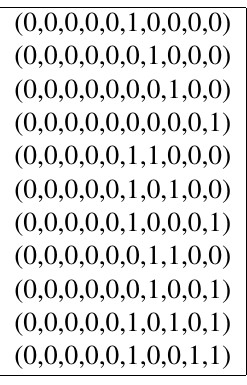
Fig. 10. Example of non-canonical steady states of the Boolean CCN shown in Figure